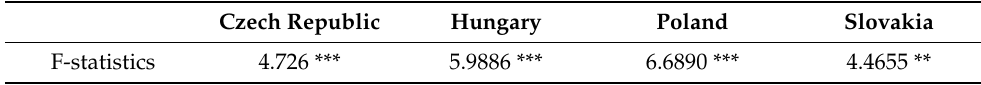
Table 5. F-statistics for cointegration relationship for export